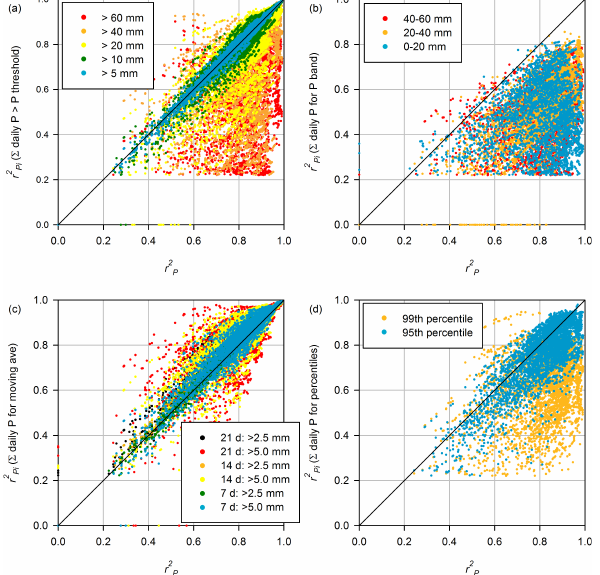
Fig. 11. Comparison of the correlation coefficients ( r 2 ) for the recharge and rainfall relationship: (x-axis) r 2 tween annual recharge and total annual rainfall and (y-axis) r 2 correlation between annual recharge and (a) sum of the daily rainfall ( P ) above the identified thresholds; (b) sum of the daily P within the identified bands; (c) sum of the daily P as moving average with identified intervals and daily thresholds; and (d) sum of 95th and 99th percentile daily P .